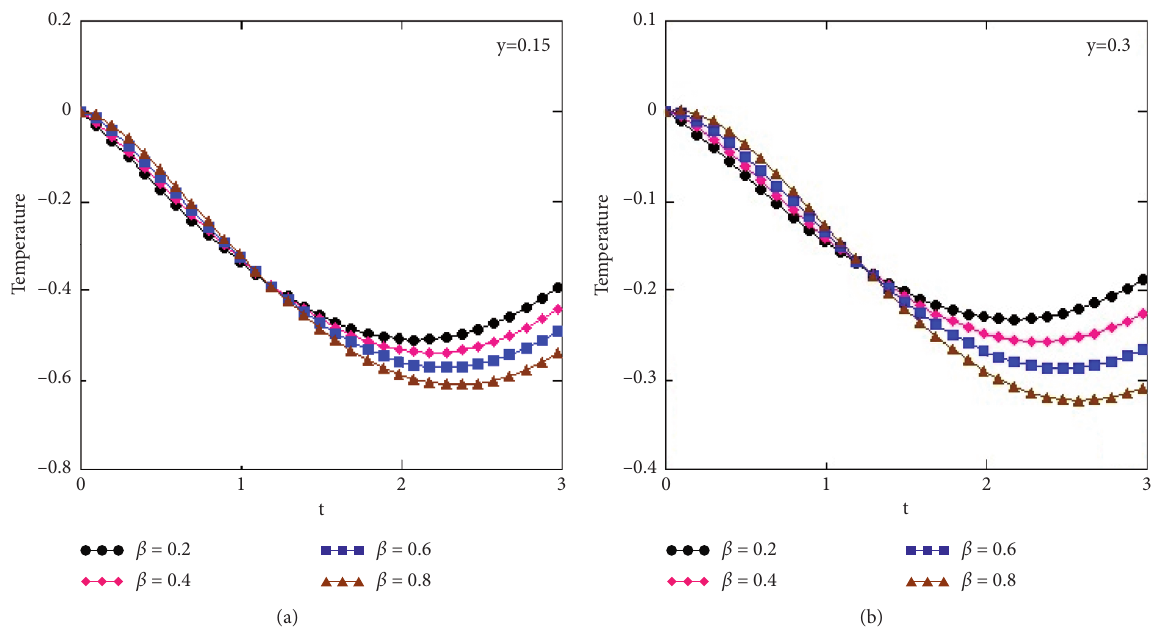
Figure 5: Profiles of dimensionless temperature verses t for β at two values of y for Pr � 20and Q � 0 . 5 and ( t ) � − sin ( π t /4 ) and f ( t ) � sin ( π t /4 ) . f 1 2